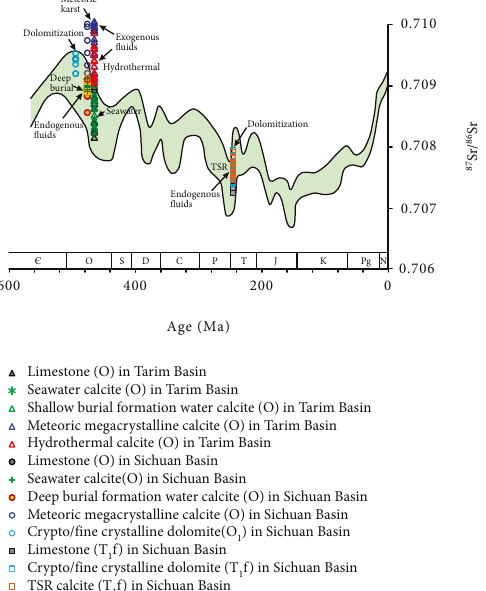
Figure 6: Strontium isotope ratios to identify di ff erent fl uid alterations in the deep marine carbonate reservoirs (the seawater 87 Sr/ 86 Sr ratios from the Cambrian to present are based on Veizer et al. ’ s report